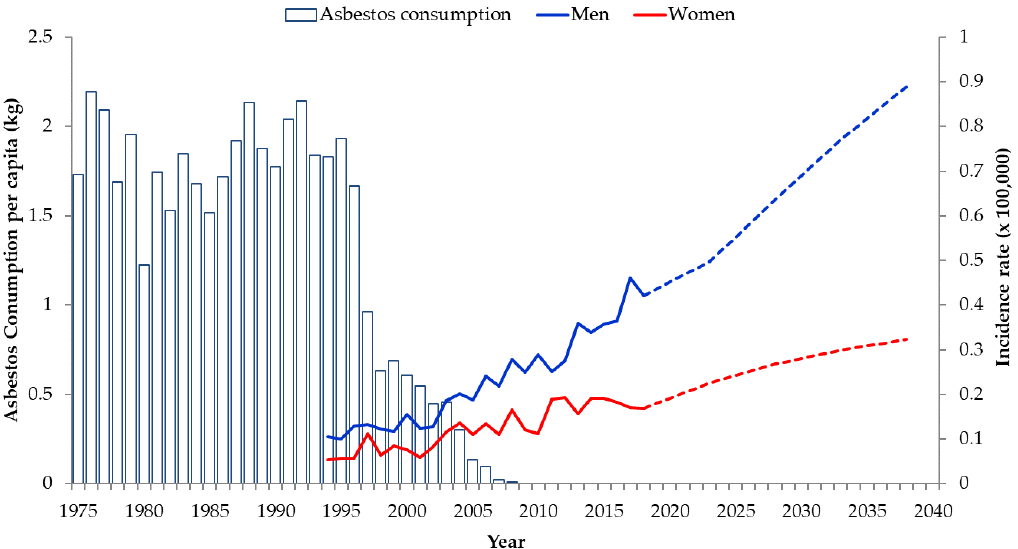
Figure 1. Asbestos consumption during the period 1975–2008 and observed (1994–2018) and predicted (2019–2038) crude incidence rates of malignant mesothelioma. In this study, the incidence of MM in South Korea was predicted to continuously increase until 2038. We first predicted the incidence of MM using an APC model and Pois- son regression model, and then compared the predicted values with actual incidence data. The Poisson regression model predicted much higher numbers of MM cases than the APC model. We judged that the values predicted by the Poisson regression model were over- estimates, concluded that the APC model was more reliable, and thus selected the APC model as the final model to predict the incidence of MM over the next 20 years. According to the APC model, the crude incidence rate was predicted to increase continuously and sharply in men. In women, the crude incidence rate was also predicted to increase contin- uously, but the rate of increase was slower compared to that for men, and the predicted increase in the number of cases was smaller. This was a follow-up of our previous study [4], which predicted the incidence of MM until 2033 in Korea for the first time using the APC model. Our previous analysis had some limitations. The available data on MM incidence were from 1994, but the early inci- dence data on KCCR had problems with reliability. Population-based regional cancer reg- istry programs, which comprise the current cancer registration system, started in 1991 in Seoul and then expanded to other regions in 1999 [30]. For regions outside Seoul, data before 1999 came from hospital-based registries. Because the hospital-based registries were passive registration systems, the number of incident cases might have been underre- ported, influencing the predictions. In addition, the range of available data was limited, so the model predictions could not be compared with actual incidence data. Furthermore, the amount of asbestos consumption was not considered in the previous prediction model. In the present study, we addressed these limitations of the 2017 analysis and up- dated the scope of future predictions. We added incidence data for the past 5 years, which were released since the previous study was conducted, and updated our predictions. By adding the latest data, we could exclude the initial cancer incidence data that reduced the reliability of the model. We also validated the model by comparing the predicted inci- dence with the actual incidence data even though the validation period was short and